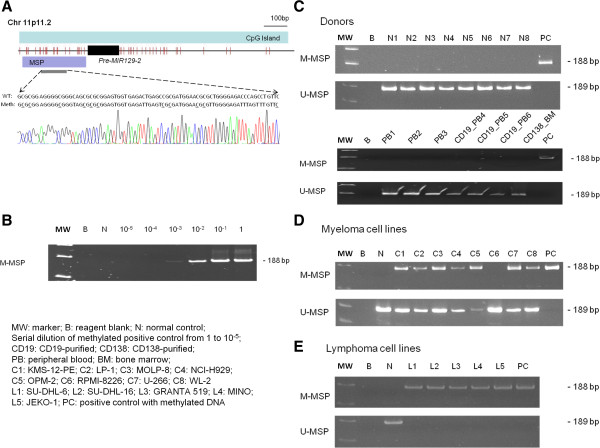
Methylation of MIR129-2. (A) Schematic diagram showing the distribution of CpG dinucleotides (solid vertical lines) along precursor MIR129-2 and its upstream promoter region. Region of MSP amplification was indicated by the text box marked as “MSP”. Sequence analysis of the MIR129-2 M-MSP product from bisulfite-treated methylated control DNA showed that the cytosine [C] residues of CpG dinucleotides were methylated and remained unchanged, whereas all the other C residues were unmethylated and were converted to thymidine [T], indicating complete bisulfite conversion and specificity of MSP. (B) Sensitivity of the methylated-MSP for the MIR129-2. (C) M- & U-MSP of 15 healthy donor controls showing no MIR129-2 methylation. (D) All myeloma cell lines, except RPMI-8226, were partially methylated, while RPMI-8226 was completely unmethylated for MIR129-2. (E) All five lymphoma cell lines were completely methylated for MIR129-2.